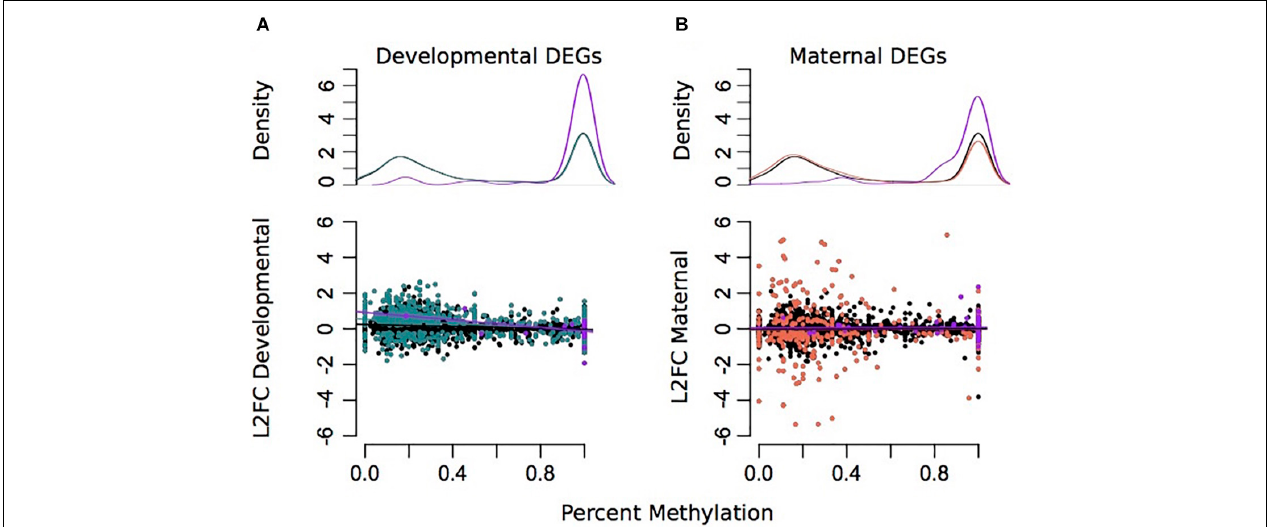
FIGURE 4 | Associations between differential gene expression and percent methylation for comparisons between developmental (A) and maternal (B) environments. The Y -axis represents the log2 fold change for each comparison. The X -axis represents the percent methylation for each gene. Gray dots represent each gene. Turquoise genes represent DEGs by developmental environment (FDR < 0.05) and coral genes represent DEGs by maternal environment (FDR < 0.05). Purple genes denote DEGs with differentially methylated